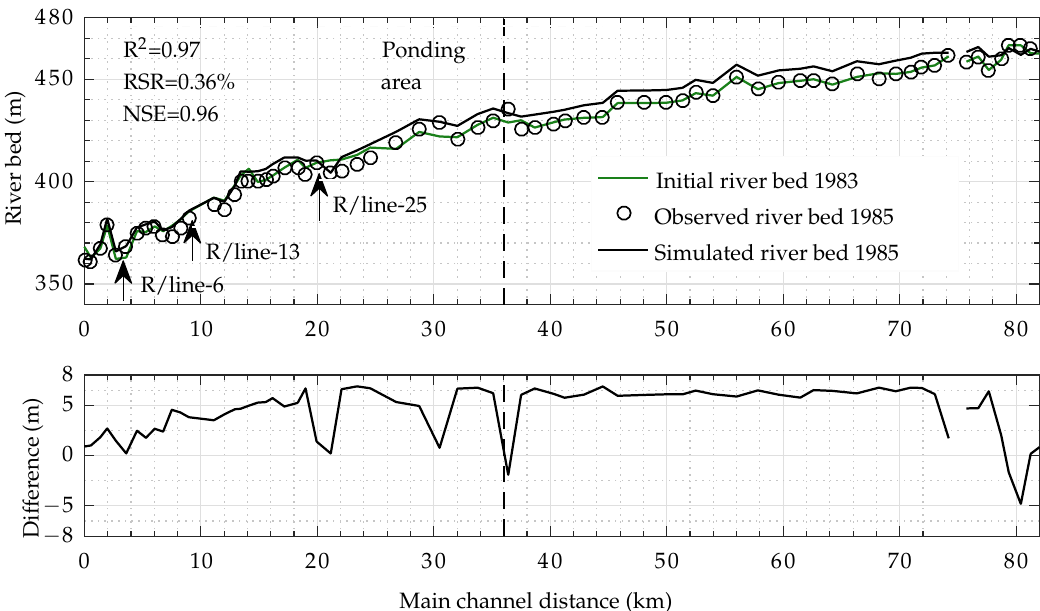
Figure 12. Longitudinal profile of mean measured and computed river bed at the end of the calibration process.